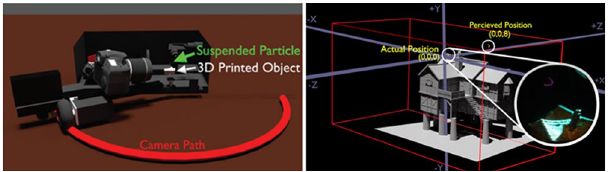
Figure 2. Experiment setup. ( a ) An OTD display projects a flat moon image at the back of a draw volume that contains a 3D printed house. The image is updated at persistence of vision frame rates (12 frames/s) using the perspective projection based on expected camera location. ( b ) A close-up of the house position, moon position, and perceived moon position in 3D